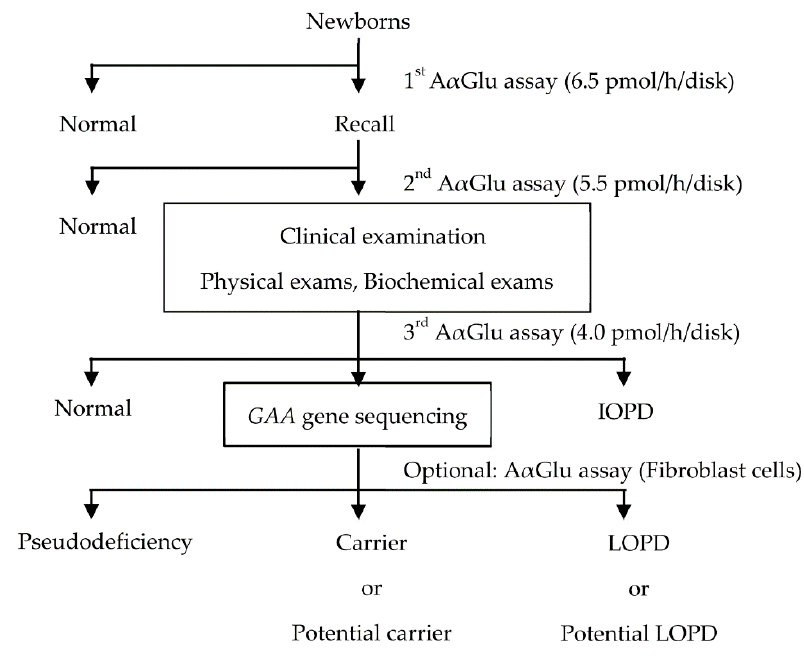
Figure 1. Flow chart of newborn screening (NBS) for Pompe disease (PD) in Japan. IOPD: infant-onset Pompe disease; LOPD: late-onset Pompe disease.